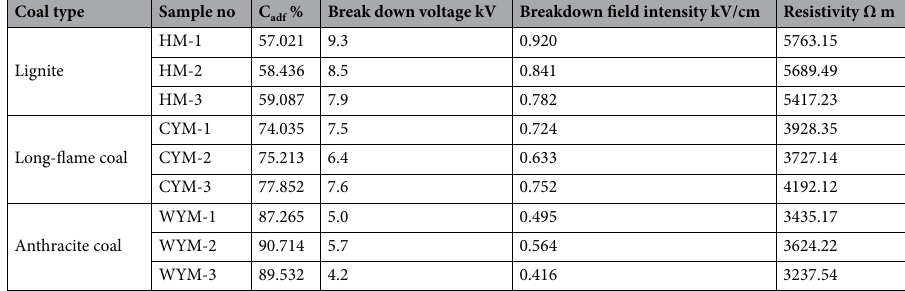
Table.1. Test results of breakdown voltages and field Intensities of different coal samples.